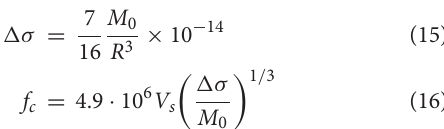
Frontiers in Built Environment |